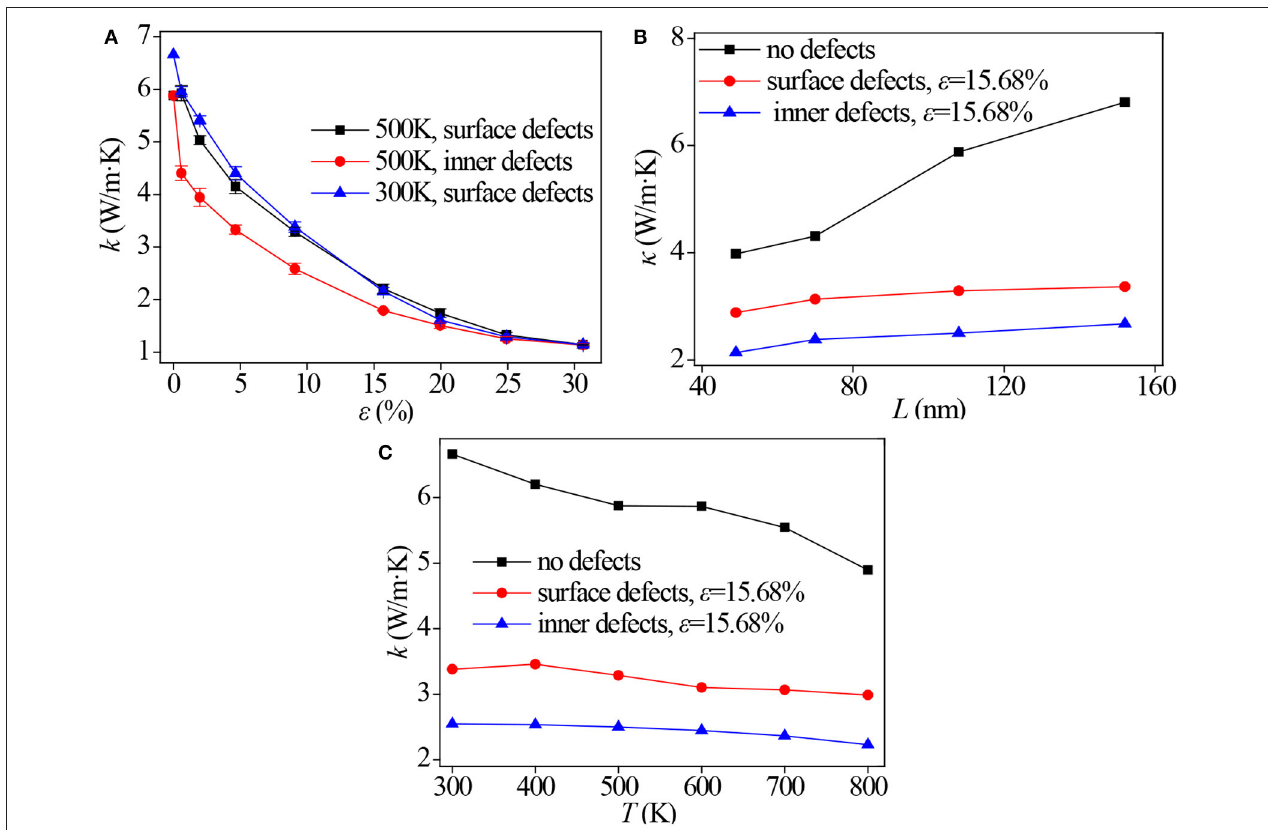
FIGURE 2 | Thermal conductivity of defective SiNWs. (A) Influence of porosity, (B) influence of length, and (C) influence of